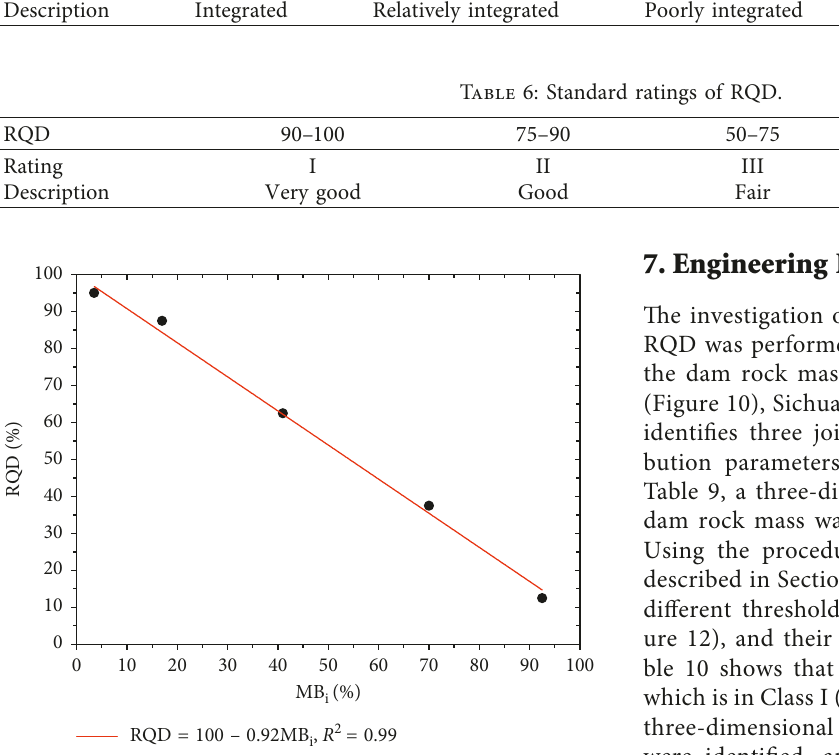
Figure 5: Correlation between the standard ratings of MB